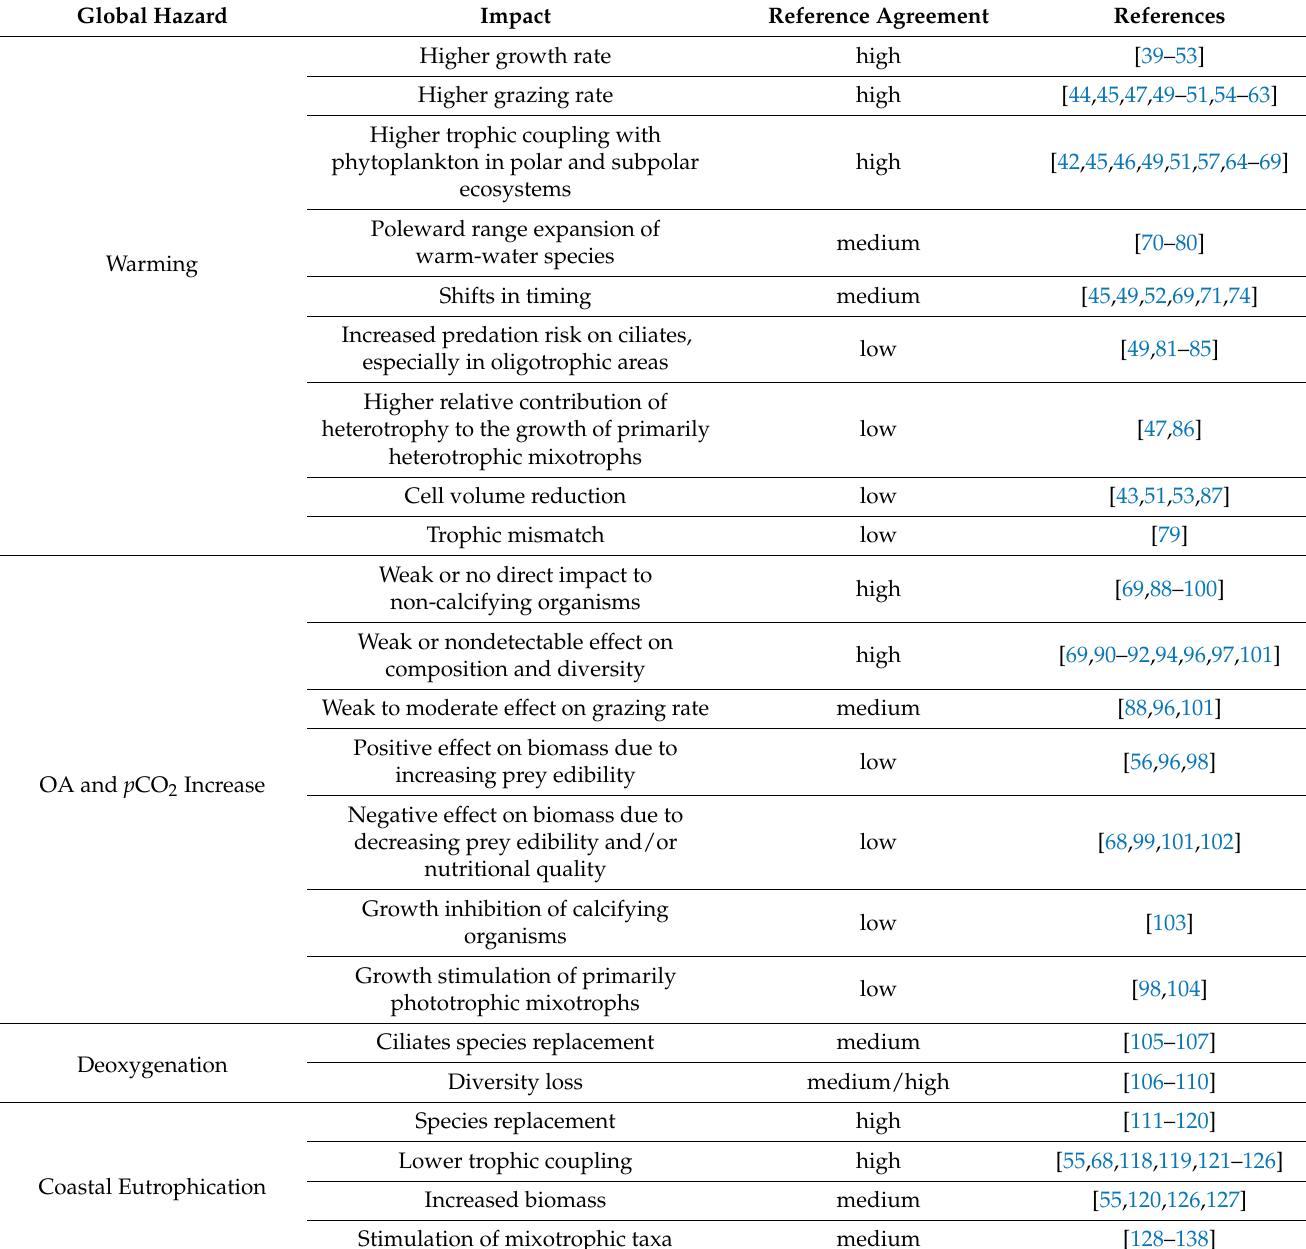
Table 1. Observed and projected impacts of global hazards on microzooplankton: the reference agreement refers to both the extent and agreement among published research. Most impacts of ocean acidification (OA) are projected for the worst-case climate